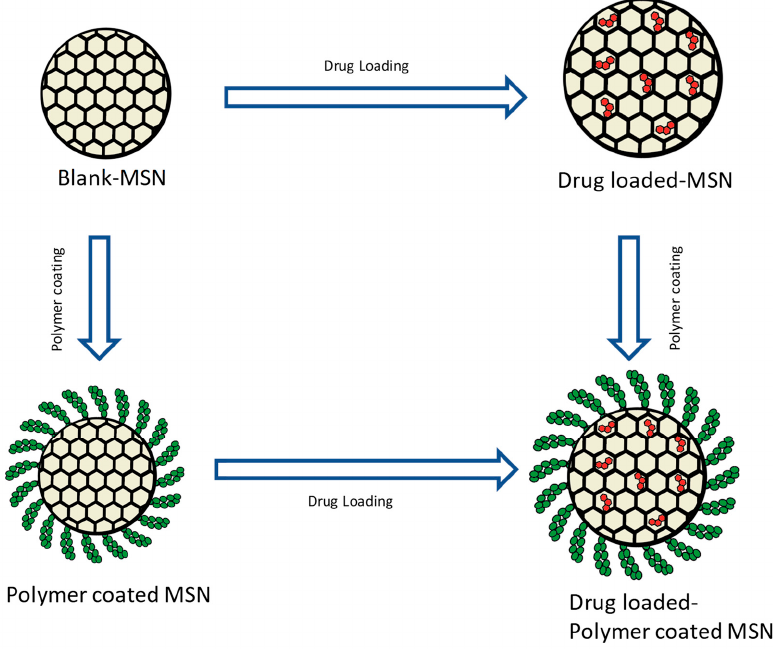
Figure 1. Graphical representation of the approaches used to prepare drug loaded MSNs coated with polymer.